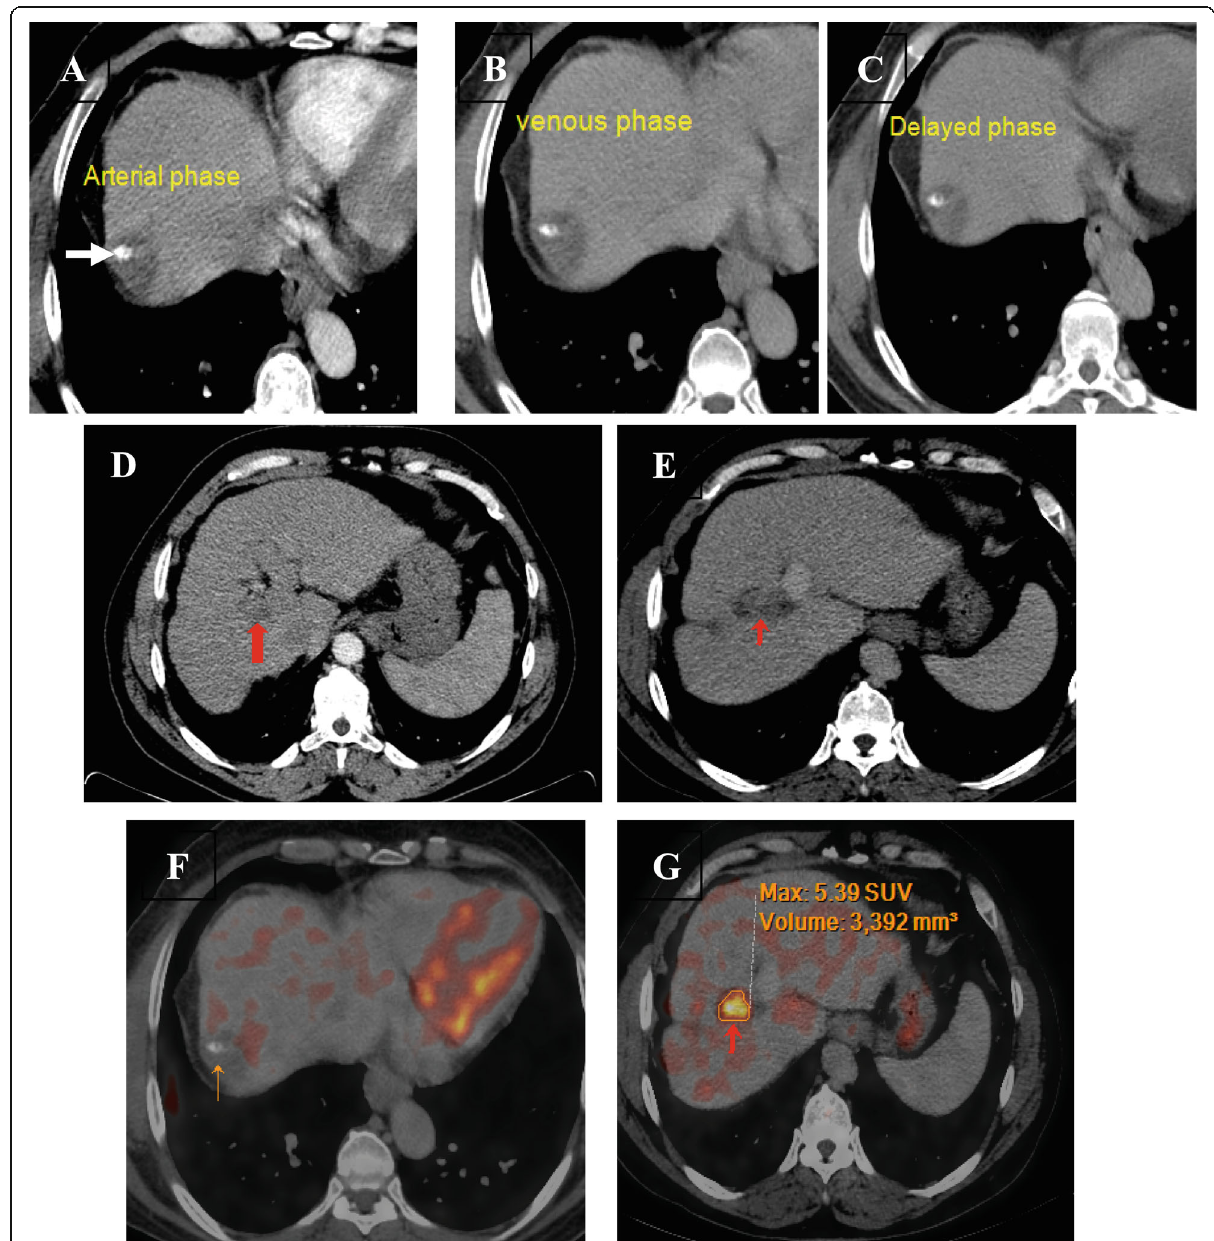
Fig. 5 a – c CECT phases show hypo dense hepatic dome focal lesion with dispersed lipiodol droplet at its centre with no contrast enchantment detected (arrow). d and e Axial CTEC shows portal vein thrombus (red arrow), not enhancing at the arterial phase. F Axial fused PET/CT image shows hyper metabolic portal vein thrombus denoting tumoral thrombus other than benign PV thrombus in spite of being not enhancing at the arterial phase ( g